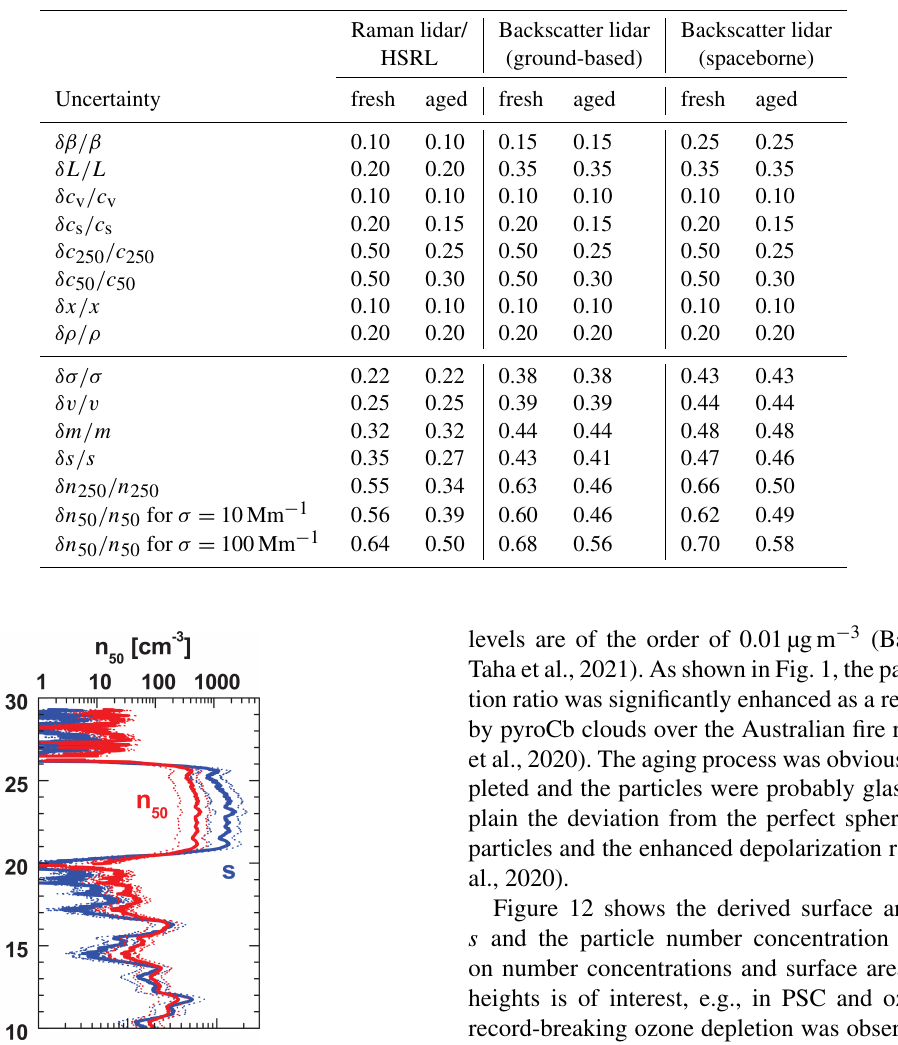
Table 4. Relative uncertainties in the conversion input parameters (upper part of the table) and in the retrieved smoke products (lower part of the table). Fresh stands for mixtures of fresh and aged smoke (or for near-source smoke). Aged denotes well-aged smoke (or smoke after long-range transport). Different lidar systems (Raman lidar/HSRL, ground-based elastic backscatter lidar, and spaceborne elastic backscatter lidar) and thus different uncertainties in the backscatter and lidar ratio profiles are considered. The uncertainties in the conversion factors and extinction exponents are estimated from Table 3. The smoke extinction coefficient is defined as σ = Lβ .